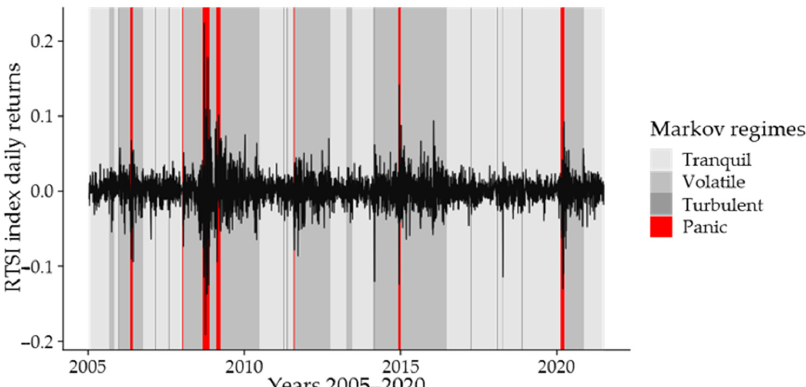
Figure 3. Time-series plots for the RTSI index returns and different regimes based on smoothed probabilities. In Table 14, we report the annualized mean returns and volatility for the RTSI index during Markov regime switching days to evaluate the relationship between hidden market regimes and subsequent Markov regimes. As in the S&P 500 index, the average return is lower and the standard deviation of returns is higher following any atypical patterns in the